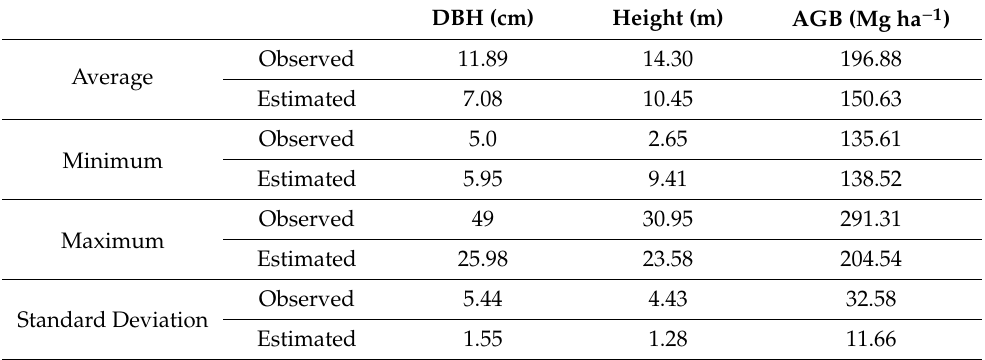
Table 5. Summary of the Observed and Estimated Field Variables Mangrove Forest in the Study Area.